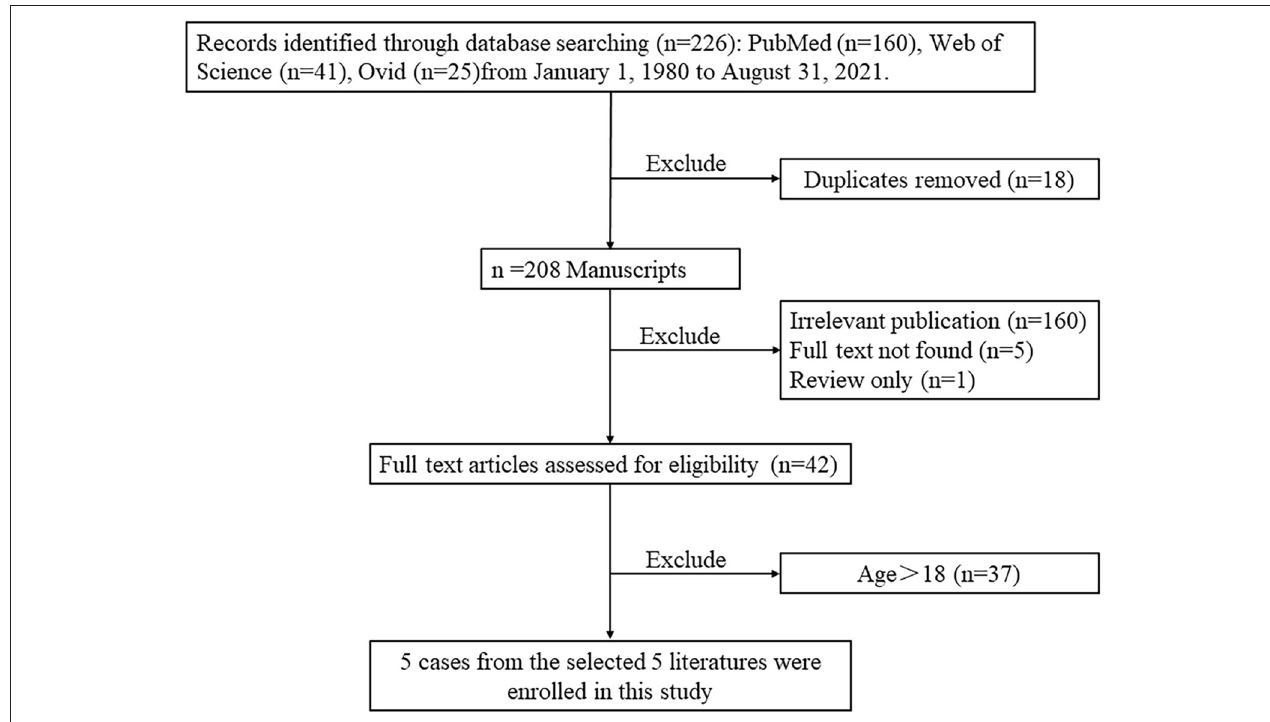
FIGURE 5 | The flow chart of the literature screening process for biatrial myxoma in children and adolescent